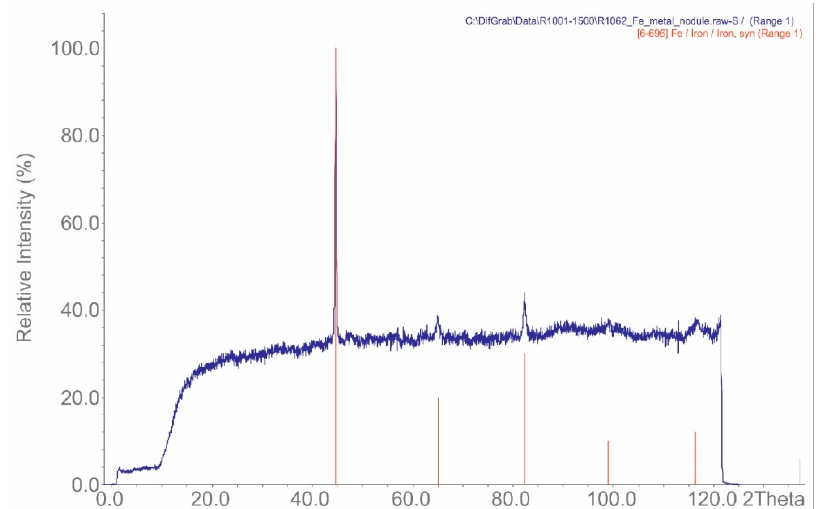
Figure 4. XRD pattern from spot XRD analysis performed on the center of one of the nodules. Diffraction lines attributable to α -Fe (JCPDS File No. 6-696).